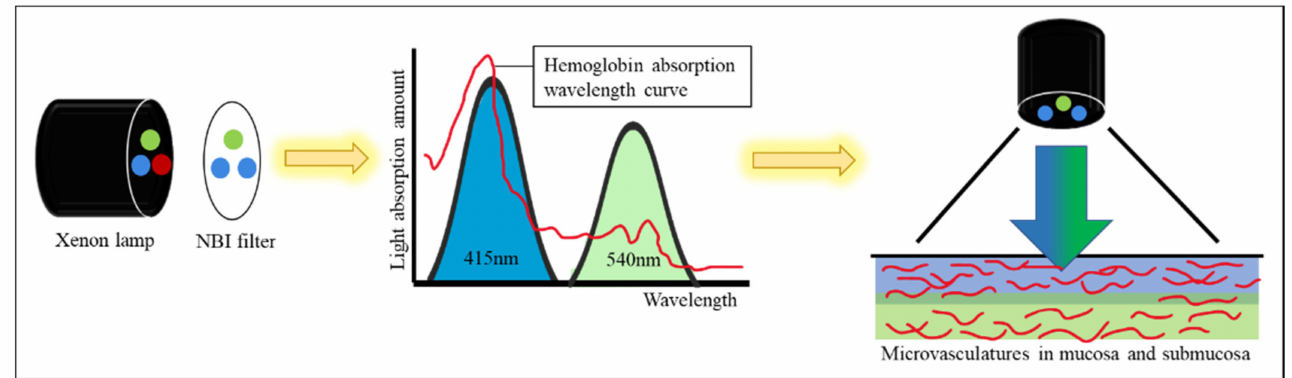
Figure 1. Physics of the NBI endoscopy system. The optical filter on the xenon lamp filters the red light to enhance the vascular and mucosa surface